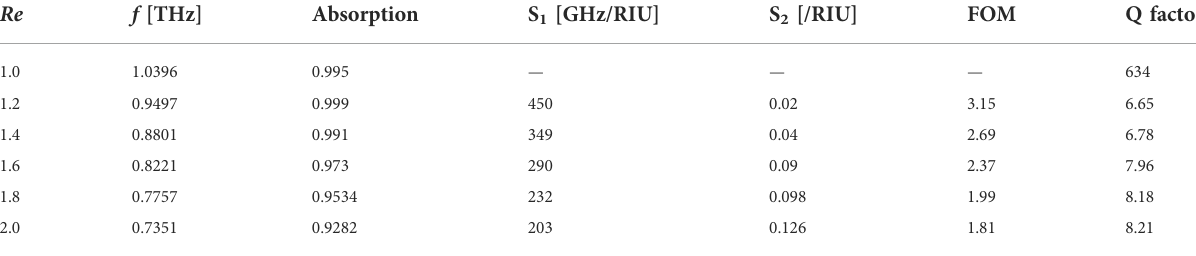
TABLE 1 Q, FOM, S 1 , S 2 when the resonant peak M1 changes with Re at h 2 (cid:1) 130 μ m.